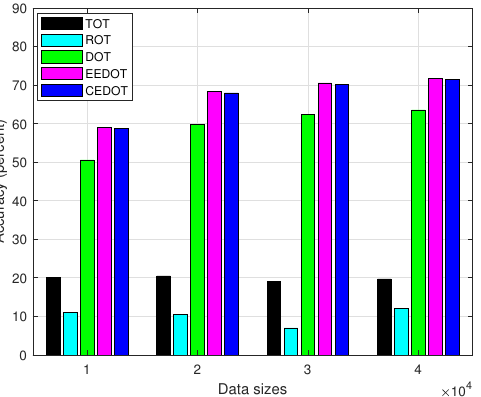
Figure 7. Comparison of the DNN accuracy for different sizes of training